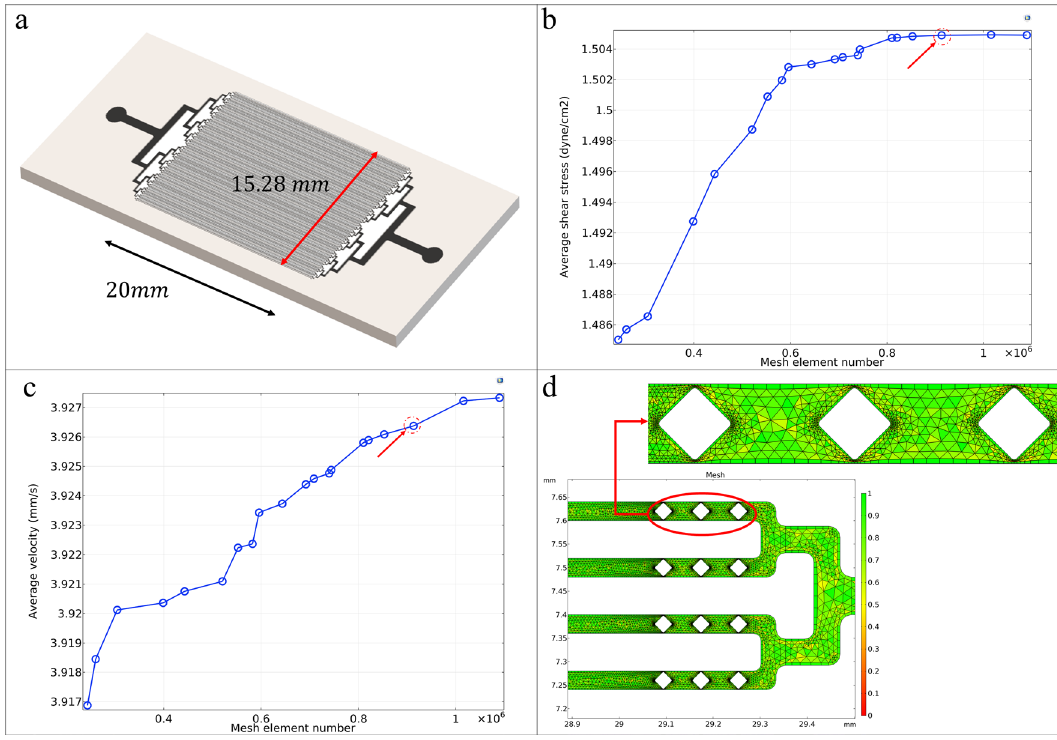
Figure 1. ( a ) Design of the microfluidic chip with 128 40 μm microchannels. ( b ) Convergence study for average shear stress in the microfluidic chip. ( c ) Convergence study for average velocity microfluidic chip. ( d ) Mesh plot around terminal microposts at the end of each microchannel. The color bar shows the mesh